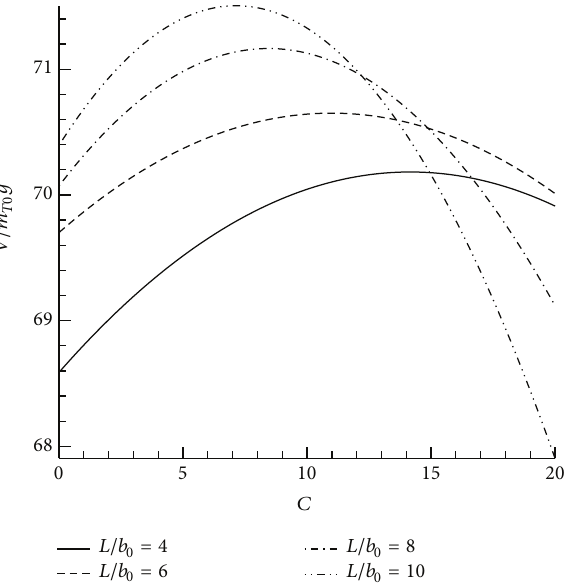
Figure 11: Tapering and length effects on bimorph with series connection, with tip mass.